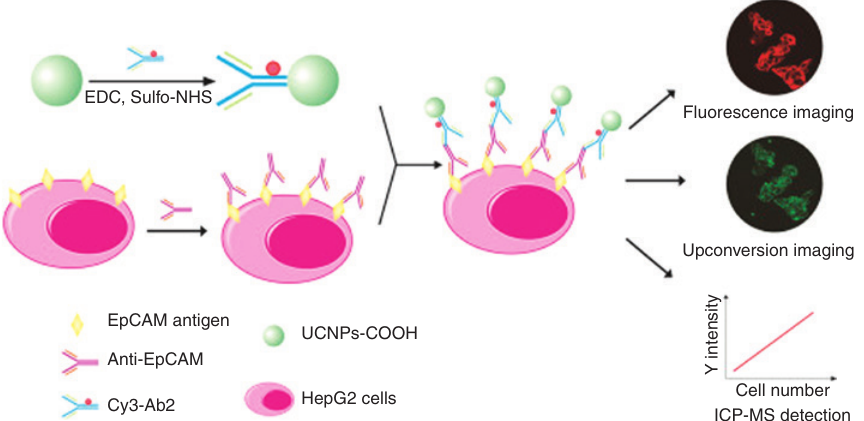
Figure 2: A multifunctional probe consisting of a recognition unit of goat anti-mouse IgG to label the anti-EpCAM antibody, a fluorescent dye (Cy3) moiety for fluorescence (FL) imaging and upconversion nanoparticles (UCNPs) tag for both inductively coupled plasma-mass spectrometry (ICP-MS) quantification and upconversion luminescence (UCL) imaging of cancer cells. Cancer cells were counted and dual- modal imaged by using ICP-MS detection and down-conversion FL/UCL. A limit of detection of 1 × 10 2 HepG2 cells and a relative standard deviation of 7.1% for seven replicate determinations of 1 × 10 3 HepG2 cells were obtained under the optimized conditions [29]. Reprinted from Yang et al. [29]. Copyright (2017), with permission from